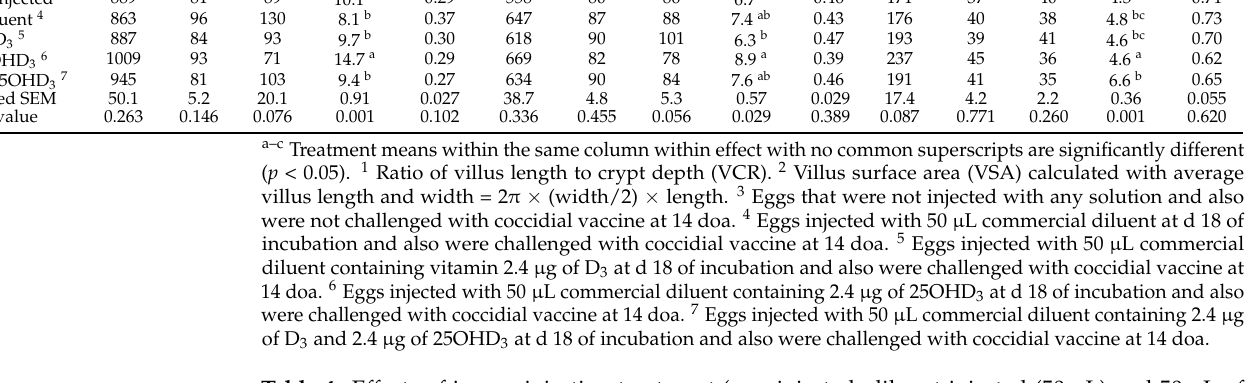
Table 4. Effects of in ovo injection treatment (non-injected, diluent-injected (50 µ L) and 50 µ L